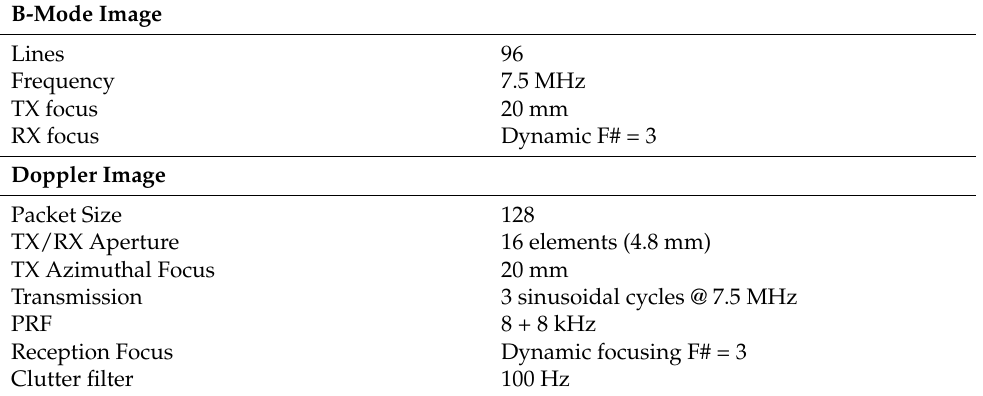
Table 2. Transmission–Reception